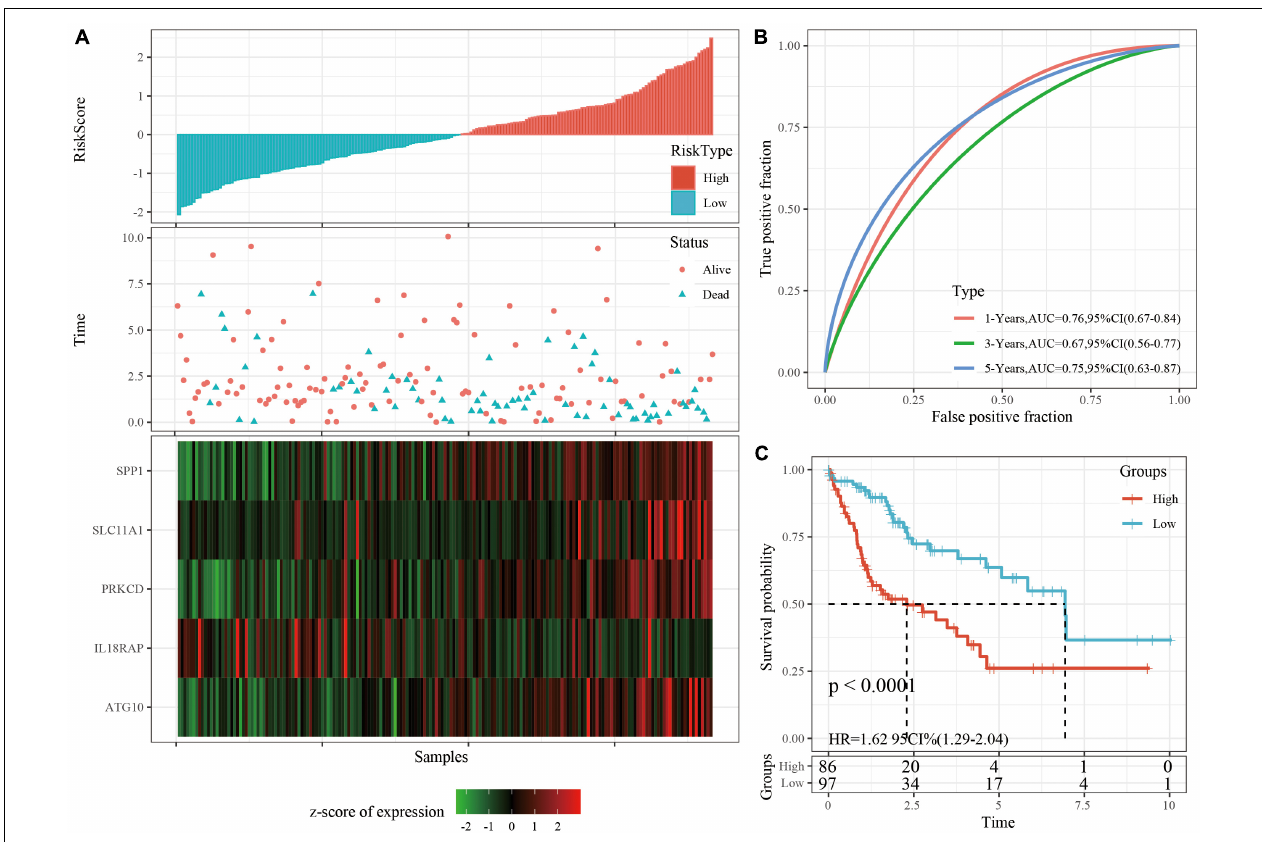
FIGURE 4 | (A) RiskScore, survival time, survival status, and 5-gene expression in TCGA validation set. (B) ROC curve and AUC of 5-gene signature classification. (C) The KM survival curve distribution of 5-gene signature in validation